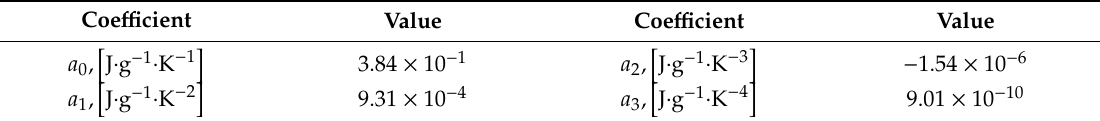
Table 4. Coe ffi cients for calculating specific heat capacity of duplex steel based on Equation (5). Coe ffi cient Value Coe ffi cient Value (cid:104) − 1 a 0 , J · g − 1 · K